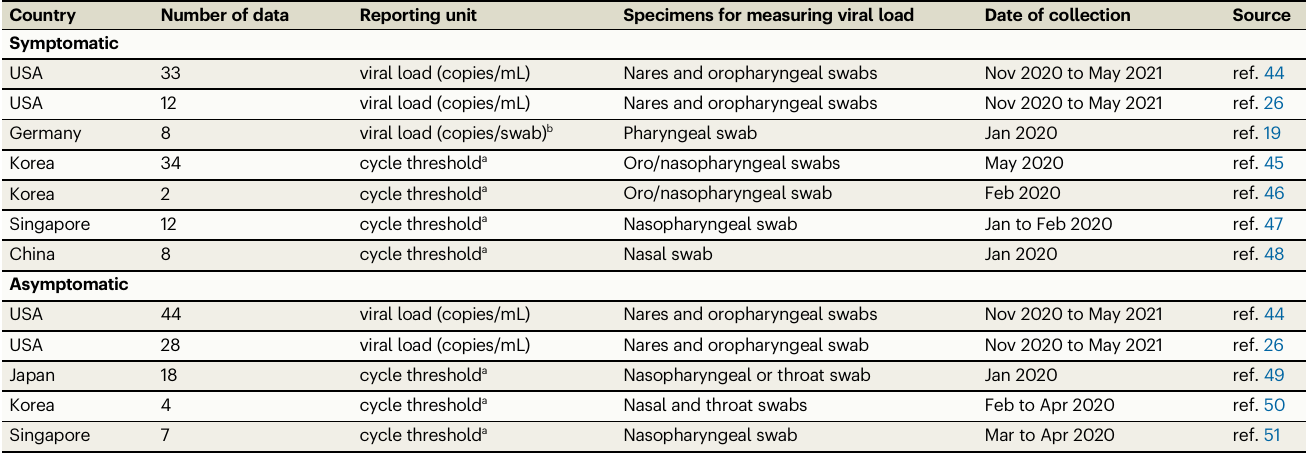
Table 1 | Summary of the viral load data used for modeling